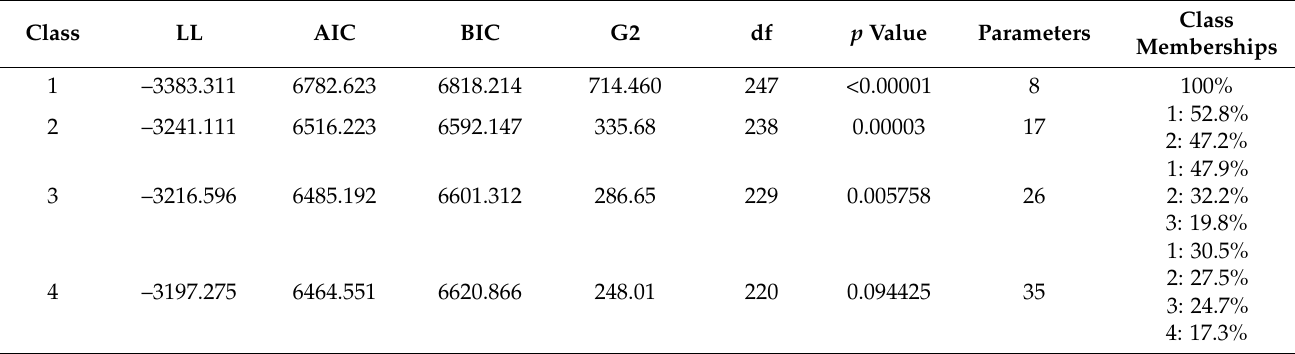
Table 3. Model fit information for the comparison of latent class